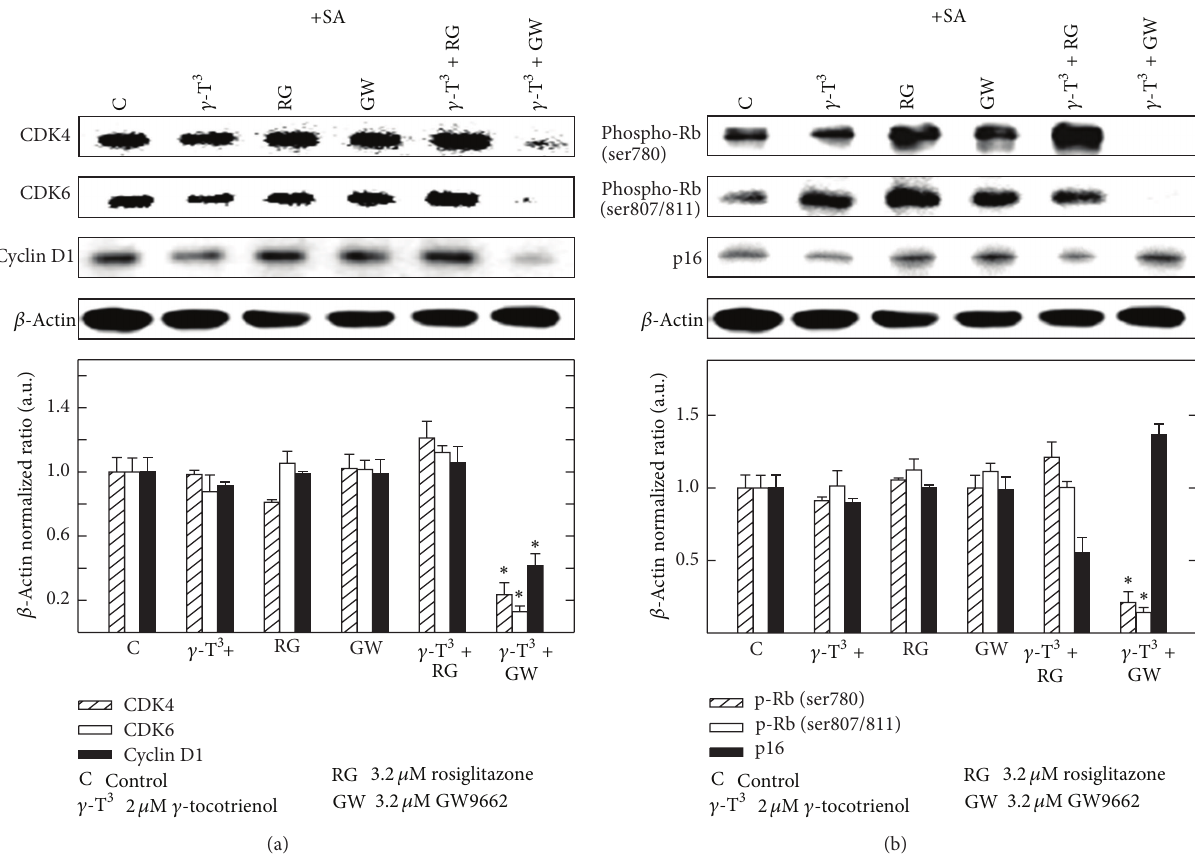
Figure 11: Western blot analysis of effect of 𝛾 -tocotrienol, rosiglitazone, and GW9662 given alone or in combination on levels of (a) cyclin and CDKs and (b) cyclin kinase inhibitors and phosphorylated retinoblastoma in +SA cells. +SA cells were plated at 1 × 1 0 6 cells/100 mm culture dish and treated with control or treatment media for 4-day incubation period. Afterwards, whole cell lysates were prepared from each treatment group for subsequent separation by polyacrylamide gel electrophoresis (50 𝜇 g/lane) followed by Western blot analysis. Scanning densitometric analysis was performed on all the blots done in triplicate and the integrated optical density of each bond was normalized with corresponding 𝛽 -actin, as shown in bar graphs below their respective Western blot images. Vertical bars in the graphs indicate the normalized integrated optical density of bands visualized in each lane ± SEM (arbitrary unit). ∗ 𝑃 < 0.05 as compared with vehicle-treated